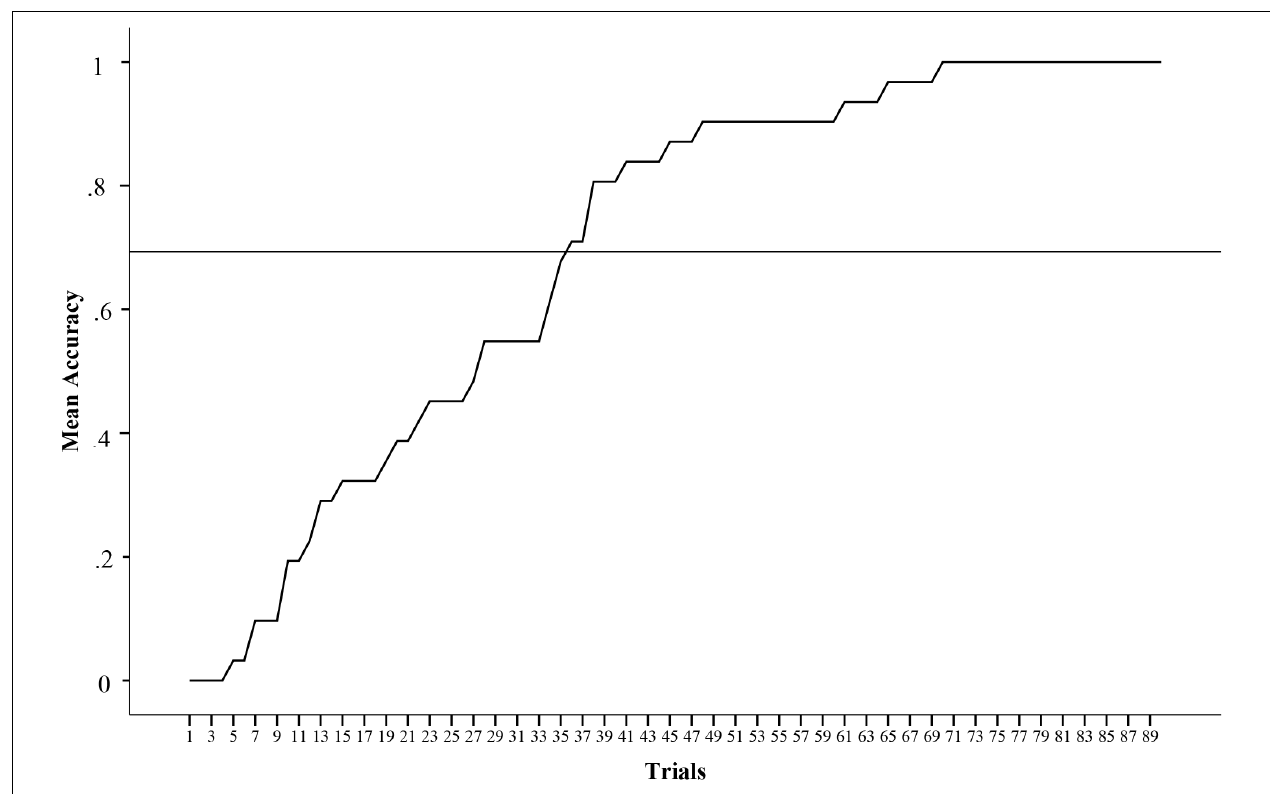
FIGURE 2 | Accuracy average compiled for experimental task 1.